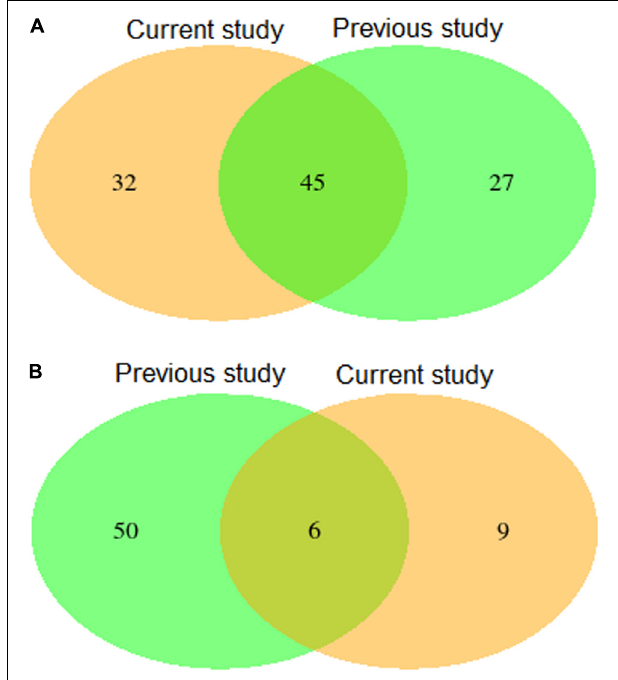
FIGURE 4 | Venn diagram showing numbers of detected and overlapping QTLs for leaf rust (A) and stripe rust resistance (B) comparing results of the present study with a previous published study by Beukert et al. (2020) (previous